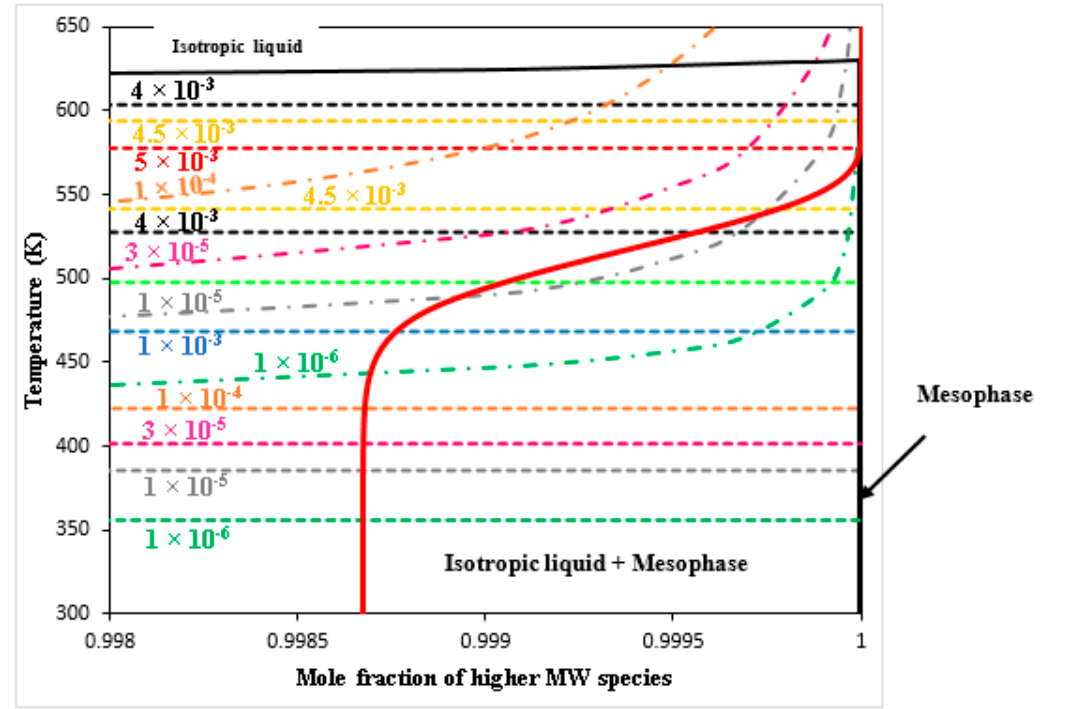
Figure 7. Zoom view of the anthracene-lean region of Figure 6. Red solid line: evaporation path of anthracene during heat treatment of a 50 g pitch sample (heating rate: 50 °C/h and carrier gas flow rate: 2300 cm 3 /min).